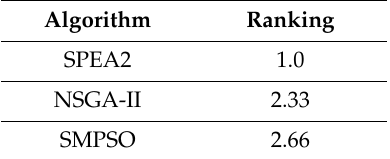
Table 4. Average ranking of the algorithms considering the I + ε metric. Friedman statistic